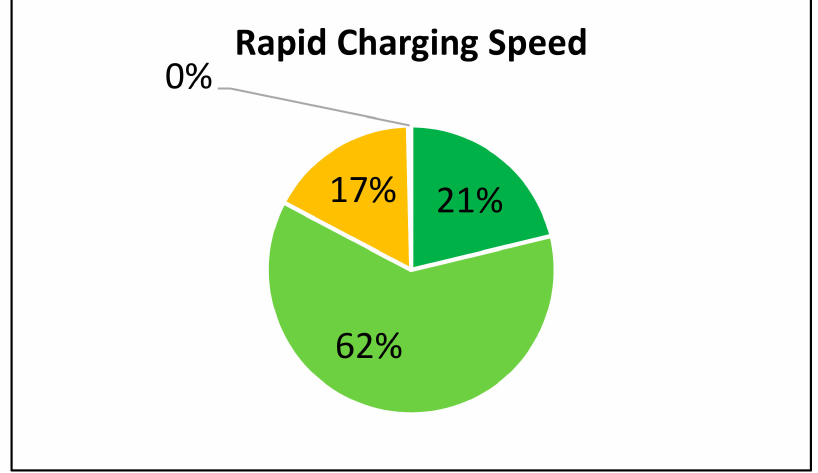
Figure 20. User satisfaction toward rapid charge point